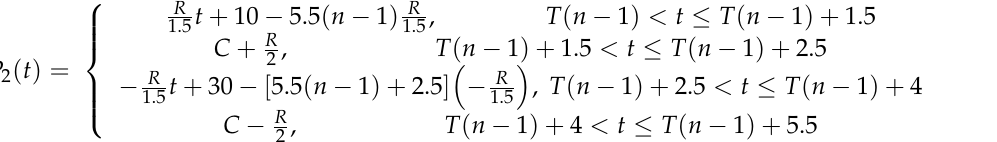
Table 6. Oscillate-stop parameters of welding heat source.